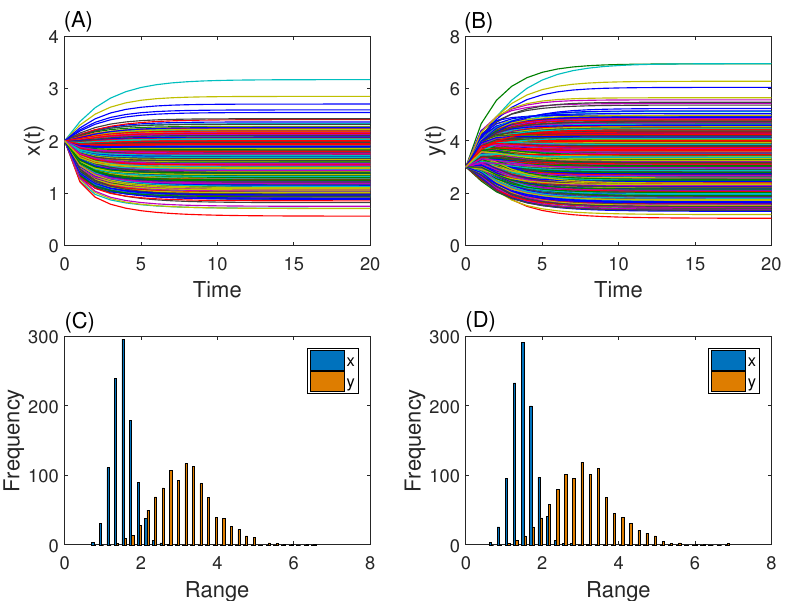
Figure 1. The 1000 generated simulations for the expression of one single gene (5). ( A ) Concentrations of mRNA x . ( B ) Concentrations of protein y . ( C ) mRNA distributions and protein concentrations at t = 5. ( D ) mRNA distributions and protein concentrations at t = 20.